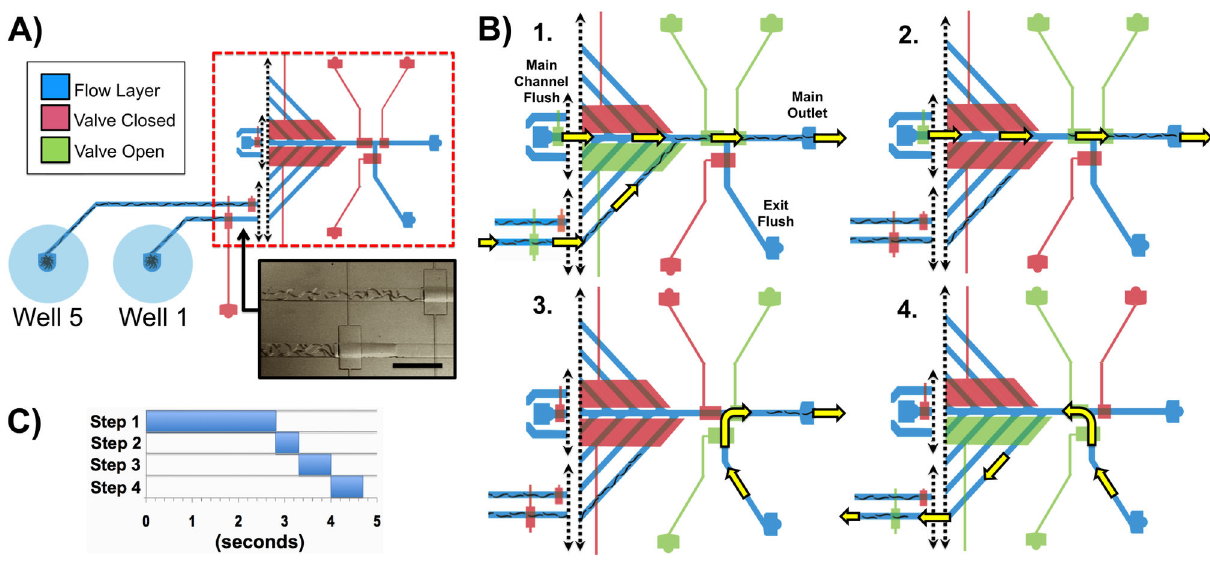
Figure 2. Automated worm population delivery sequence. A) Schematic of the device showing areas active during the sequence example as the worms are pre-staged at the first set of control valves. An image of pre-staged C . elegans worms is below the schematic (scale bar is 1 mm). B) Illustration of all steps for one full sequence cycle. Step 1: Appropriate valves open as the gasket is pressurized to send Well 1’s population to the main channel, where Main Channel Flush then accelerates the worms’ transport to the main exit. Step 2: Excess worms are cleared from the main channel towards the Main Outlet via flow from Main Channel Flush . Step 3: Flow from Exit Flush delivers the worms from the Main Outlet to an off-chip location. Step 4: “Flushback”; Exit Flush flow is redirected backwards to clear any remaining worms in the well channel back to Well 1 . This step is executed on Wells 1-4 only after finishing Steps 1-3 on each of them. C) Timings for each